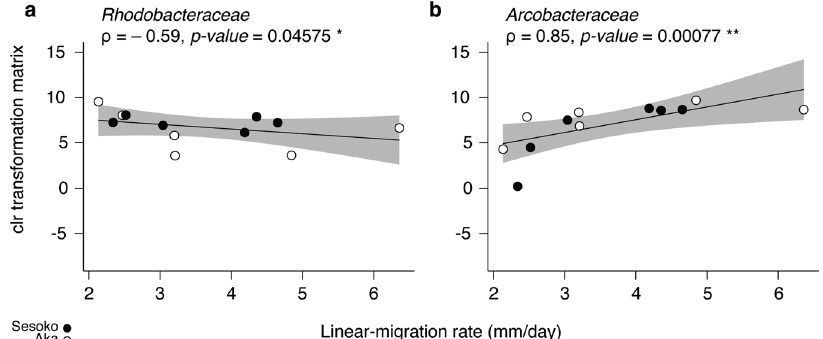
Fig. 4 Spearman ’ s rank correlation with the clr-transformed abundance of families Rhodobacteraceae and Arcobacteraceae to migration rates. The clr-transformed matrix for each family ( a : Rhodobacteraceae and b : Arcobacteraceae ) was summed across the OTUs. Signi fi cant correlation marked as * p < 0.05 and ** p < 0.01. The shaded grey area represents the 95% con fi dence